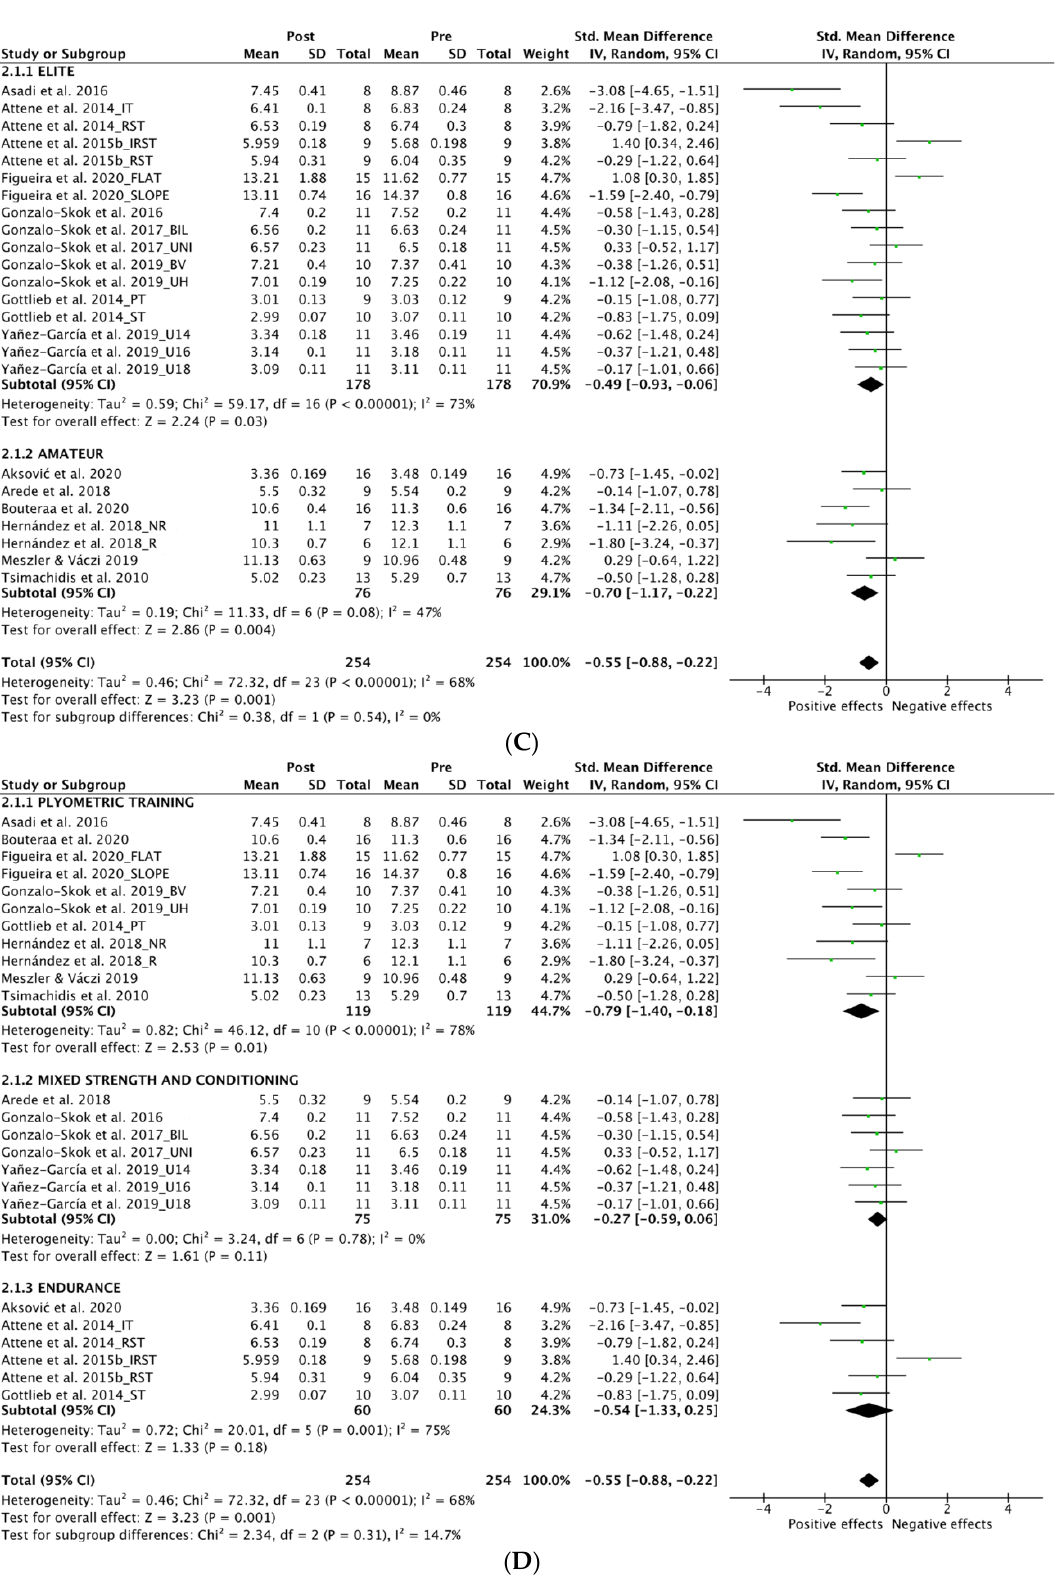
Figure 6. Forest Plot comparing the effect of multidisciplinary interventions on neuromuscular power horizontal (NPH) considering sub-groups analysis for age ( A ), gender ( B ), level ( C ) and type of intervention ( D ) [49 – 51,61,62,64 – 68,70,71,74,77,78].